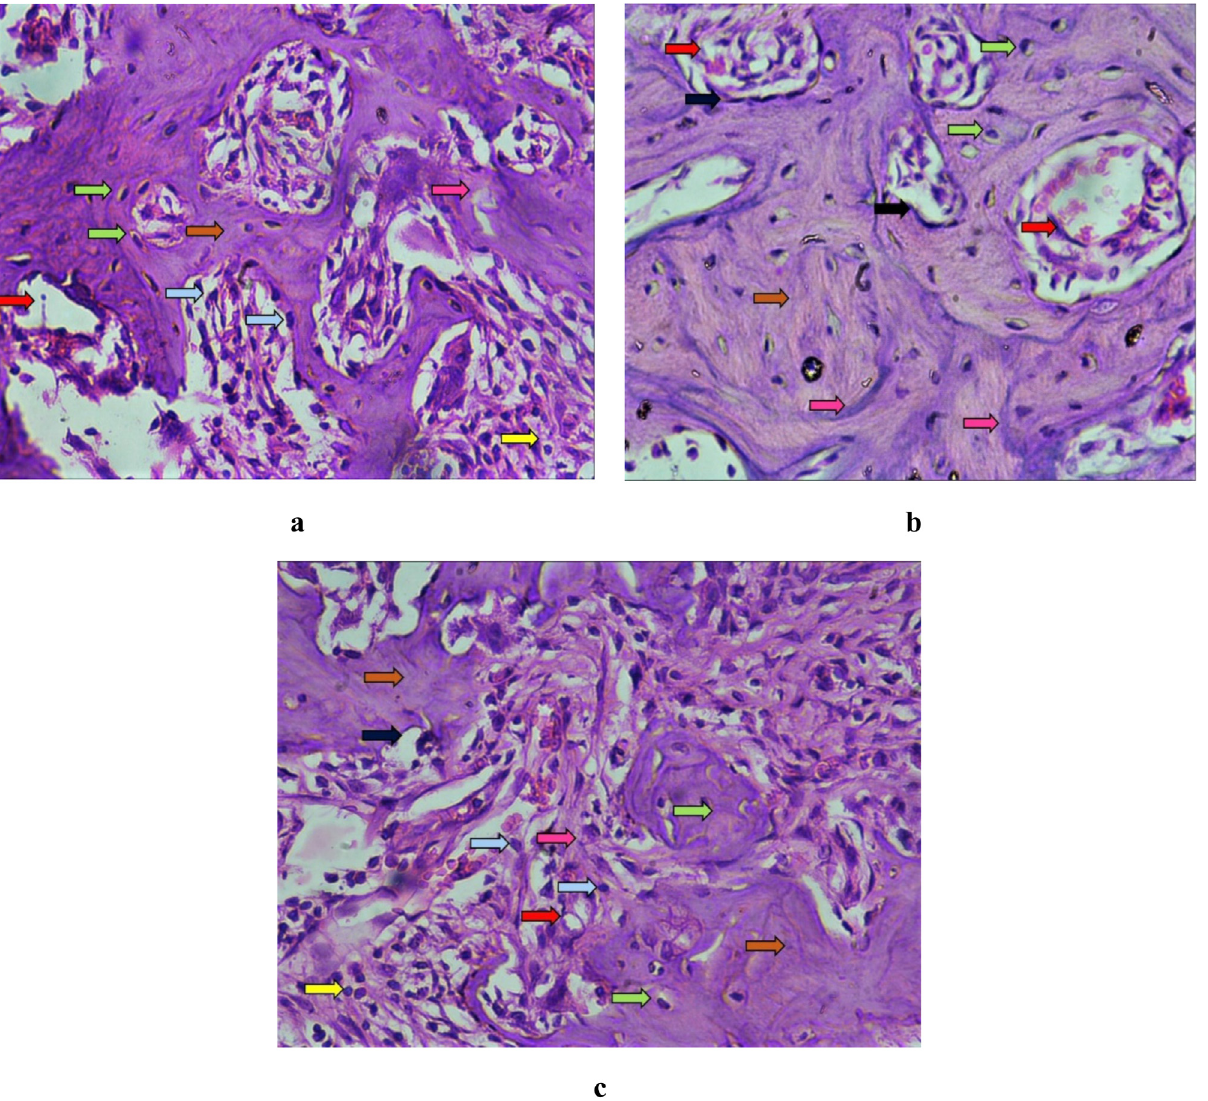
Fig. 8. Photomicrograph of Group A (control) (a), B (mucoadhesive paste with phenytoin) (b), and C (mucoadhesive paste without phenytoin) (c), 21 days after extraction, H and E stain, 40 (cid:3) . These images depict new bone formation. Blood vessels (red arrow), in fl ammatory cells (yellow arrow), osteocytes (green arrow) are seen. Well-developed haversian system can been seen in (b). Bone lining cells (dark blue arrow) marginate the bone